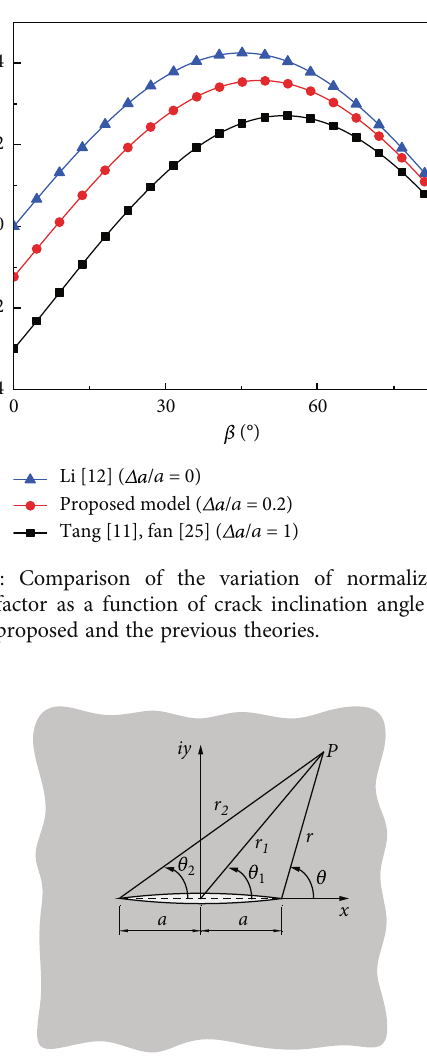
Figure 10: The coordinate system of the crack.